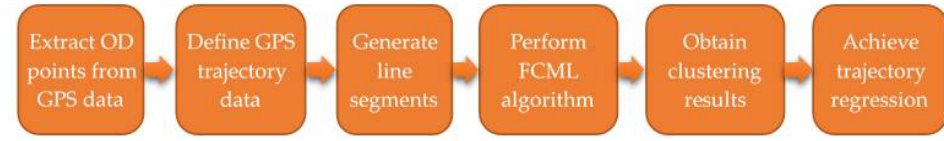
Figure 1. Flowchart of the Lagrange-based fuzzy C-means clustering algorithm (FCML).